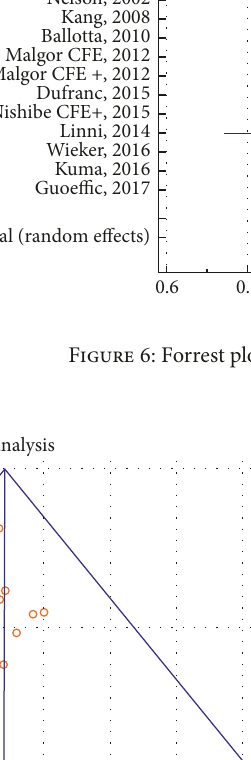
Figure 7: Funnel plot of studies about PP at I year in CFE group by Egger test: asymmetrical.